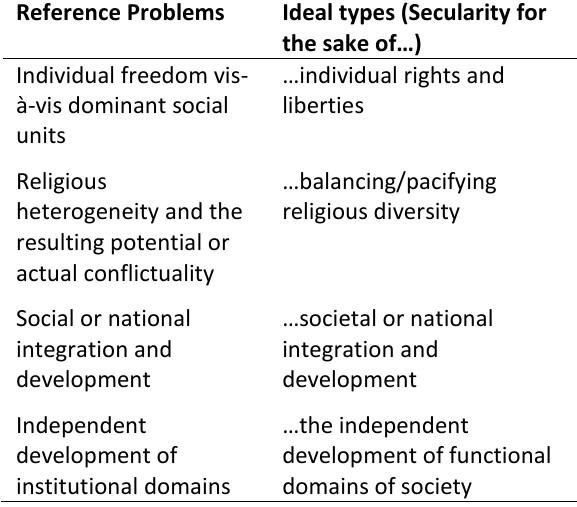
Table 3. Multiple